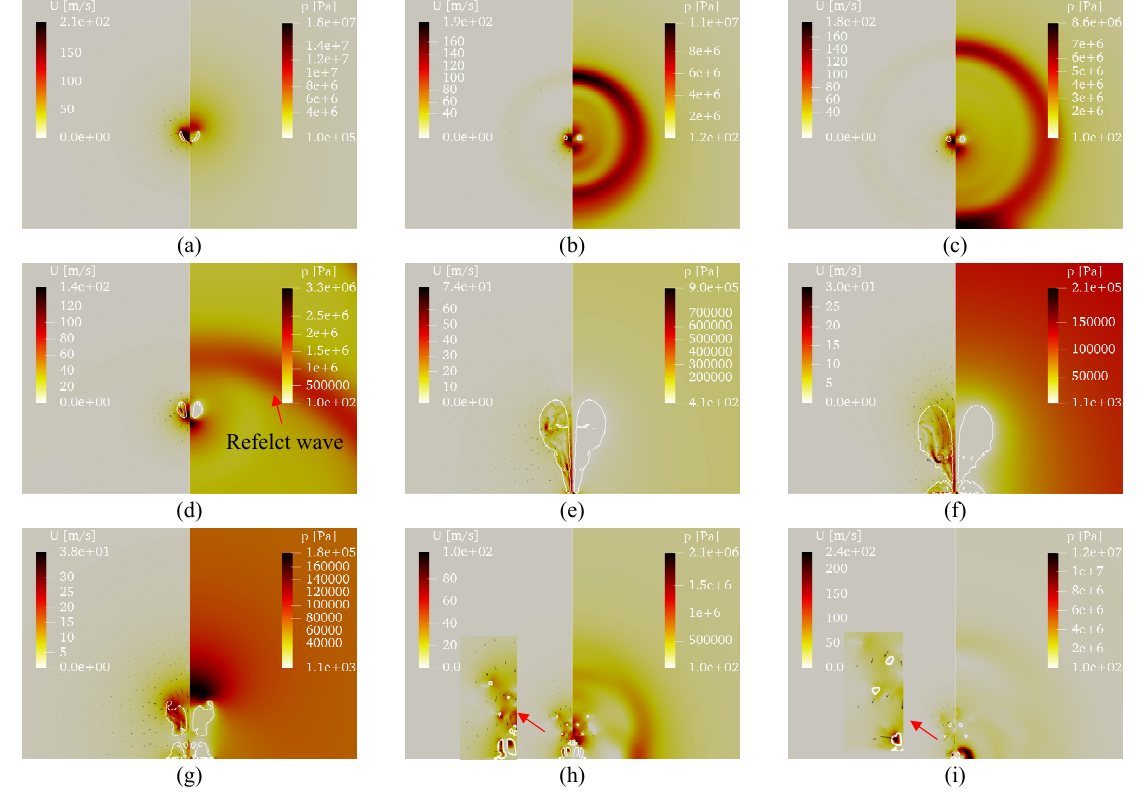
Figure 7. Velocity (left-hand side) and pressure (right-hand side) fields in the process of multi-pe- riod cavitation collapse when γ = 1.7. ( a ) 𝑡 ∗ = 1.107, ( b ) 𝑡 ∗ =1.116, ( c ) 𝑡 ∗ = 1.119, ( d ) 𝑡 ∗ = 1.133, ( e ) 𝑡 ∗ = 1.434, ( f ) 𝑡 ∗ = 1.865, ( g ) 𝑡 ∗ = 2.295, ( h ) 𝑡 ∗ = 2.410, and ( i ) 𝑡 ∗ =